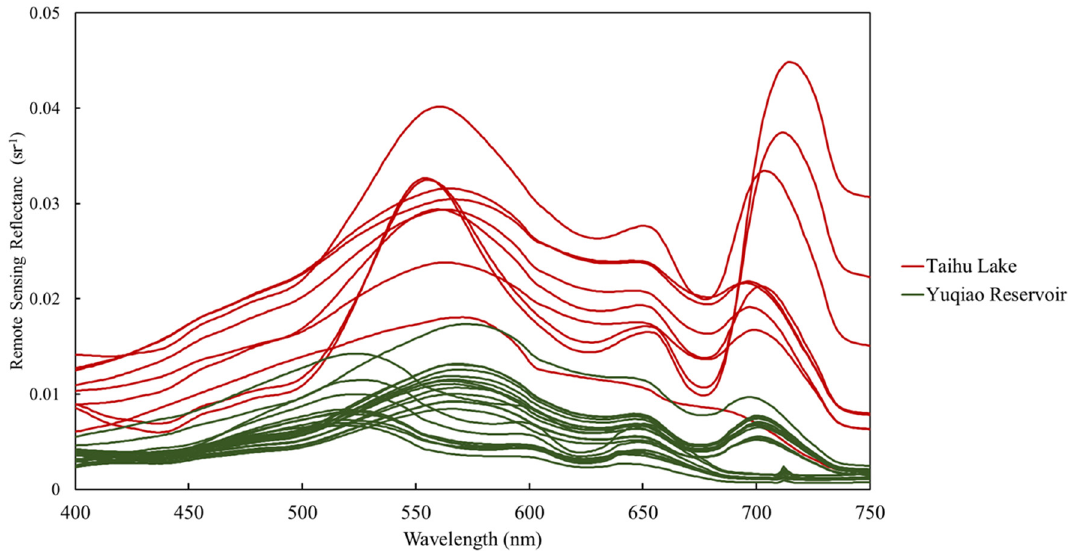
Figure 5. Remote sensing reflectance spectra of water surfaces measured with a field spectrometer at Taihu Lake and the Yuqiao Reservoir.